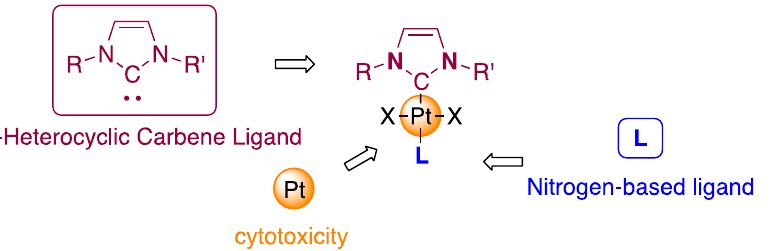
Figure 1. Chemical structures of platinum N-heterocyclic carbene (NHC) complexes that show high cytotoxic activities against cancer cells.